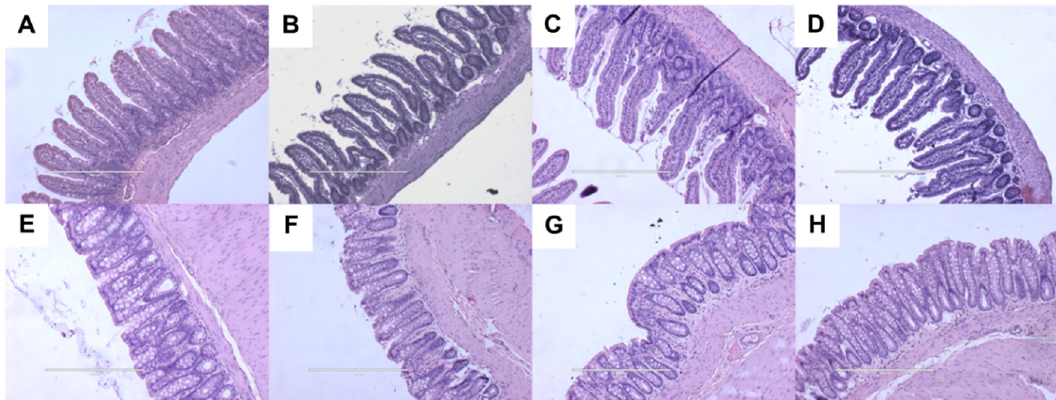
Figure 5. Haematoxylin and eosin staining of ileum ( A – D ) and colon ( E – H ; magnification ×20; scale bar = 200 µm) in corn starch diet-fed rats ( A , E ), corn starch diet-fed rats treated with Garcinia dulcis rind powder ( B , F ), high-carbohydrate, high-fat diet-fed rats ( C , G ) and high-carbohydrate, high-fat diet-fed rats treated with Garcinia dulcis rind powder ( D , H ).